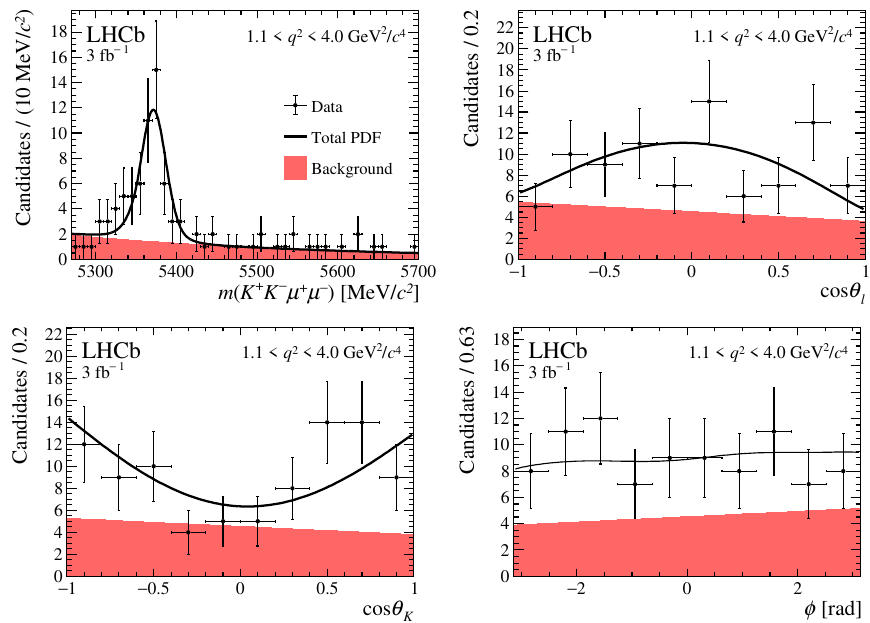
Figure 15 . Mass and angular distributions of B 0 1 . 1 < q 2 < 4 . 0 GeV 2 /c 4 for data taken in 2011–2012. The data are overlaid with the projections of the fitted